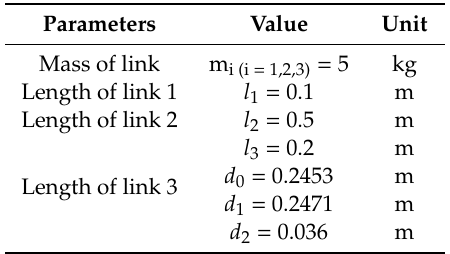
Table 1. The system parameters of the